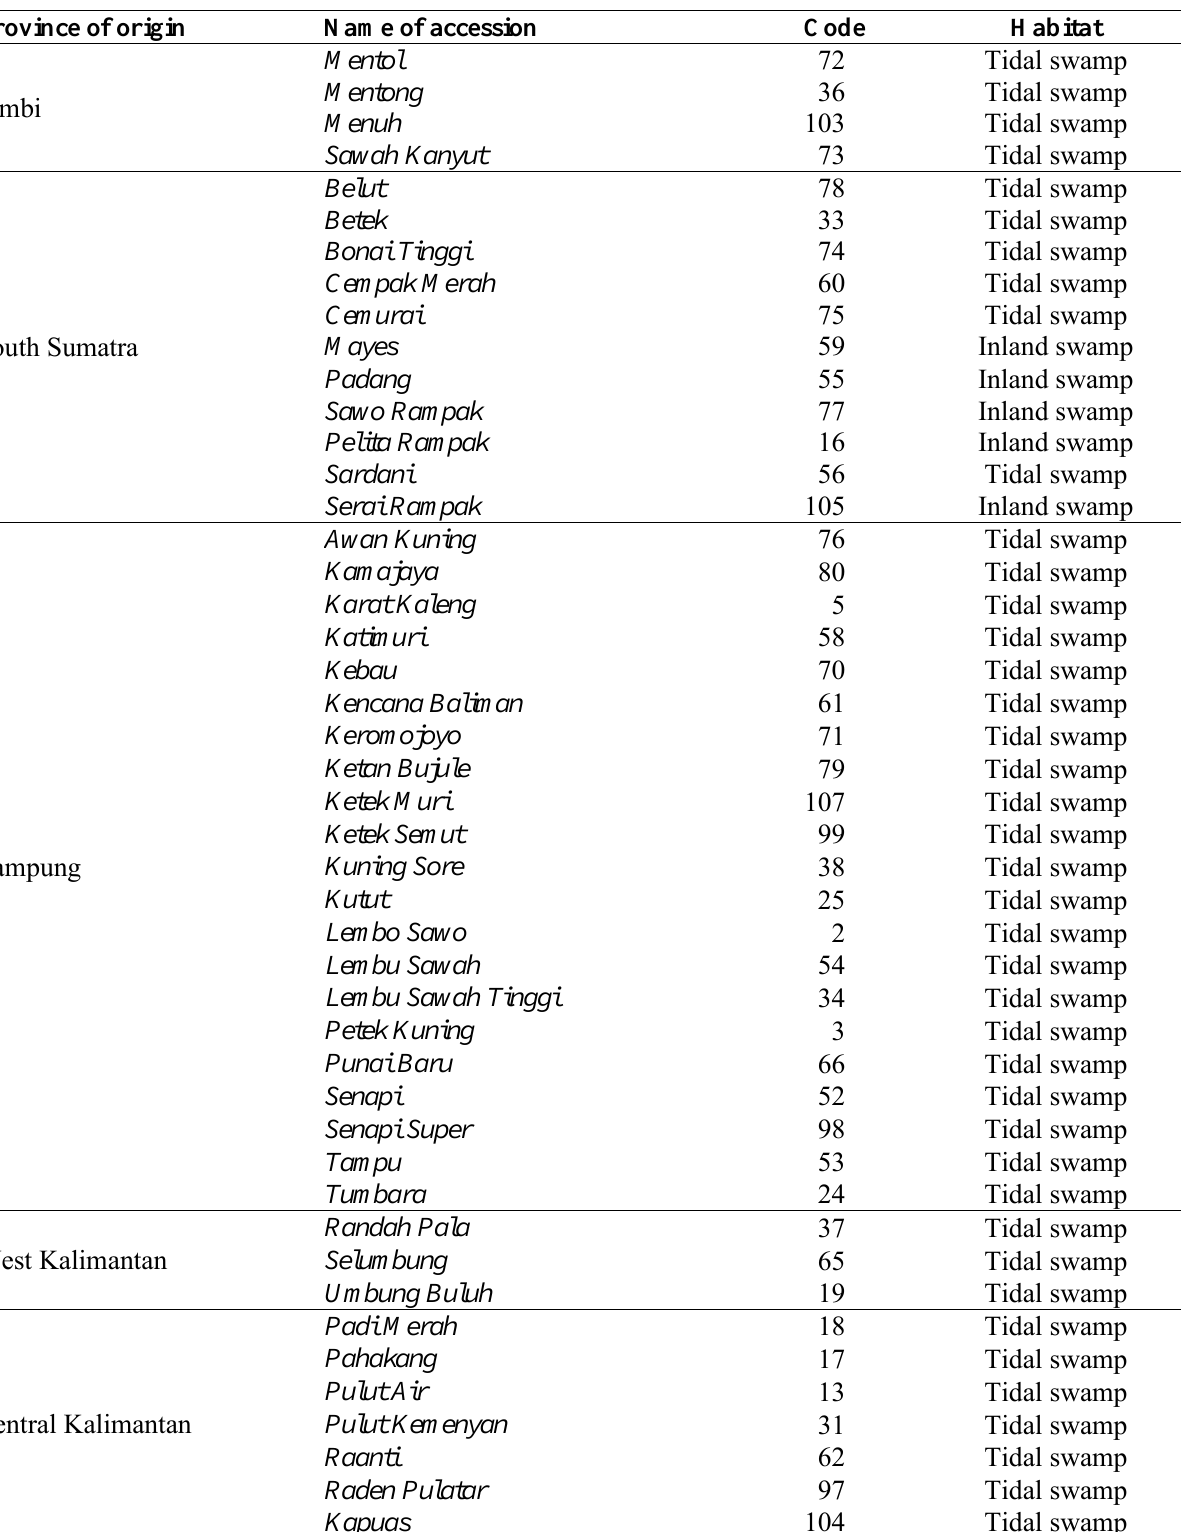
Table A1. List of Indonesian swamp rice accessions used in the study, including their origins and natural